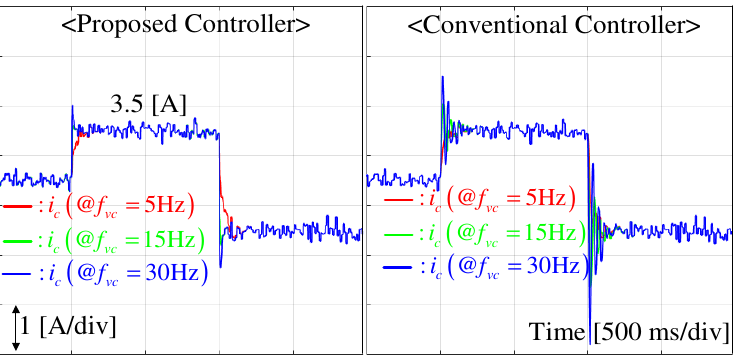
Figure 9. Inductor current response comparison at f vc = 5, 15, and 30 Hz and pulse reference tracking mode of R L = 20 Ω